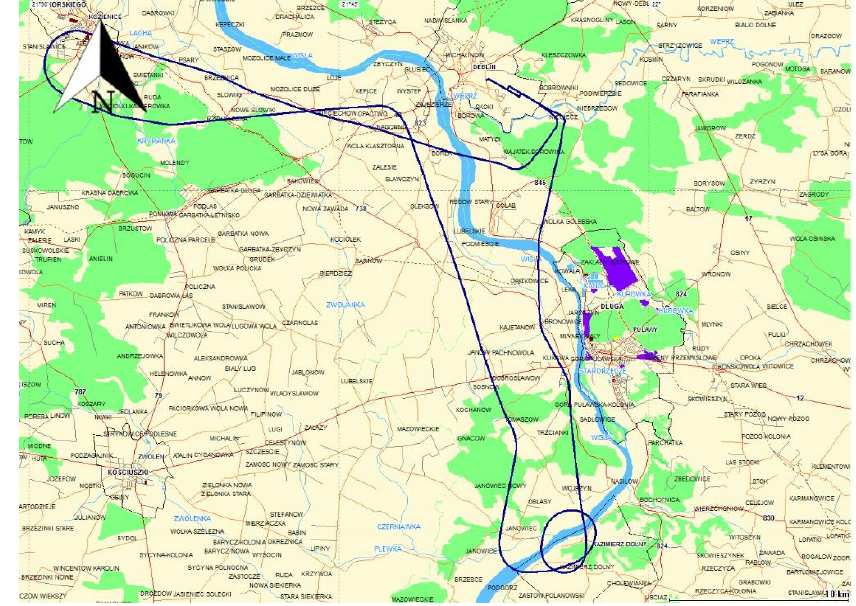
Figure 1. The trajectory of aircraft in horizontal plane.